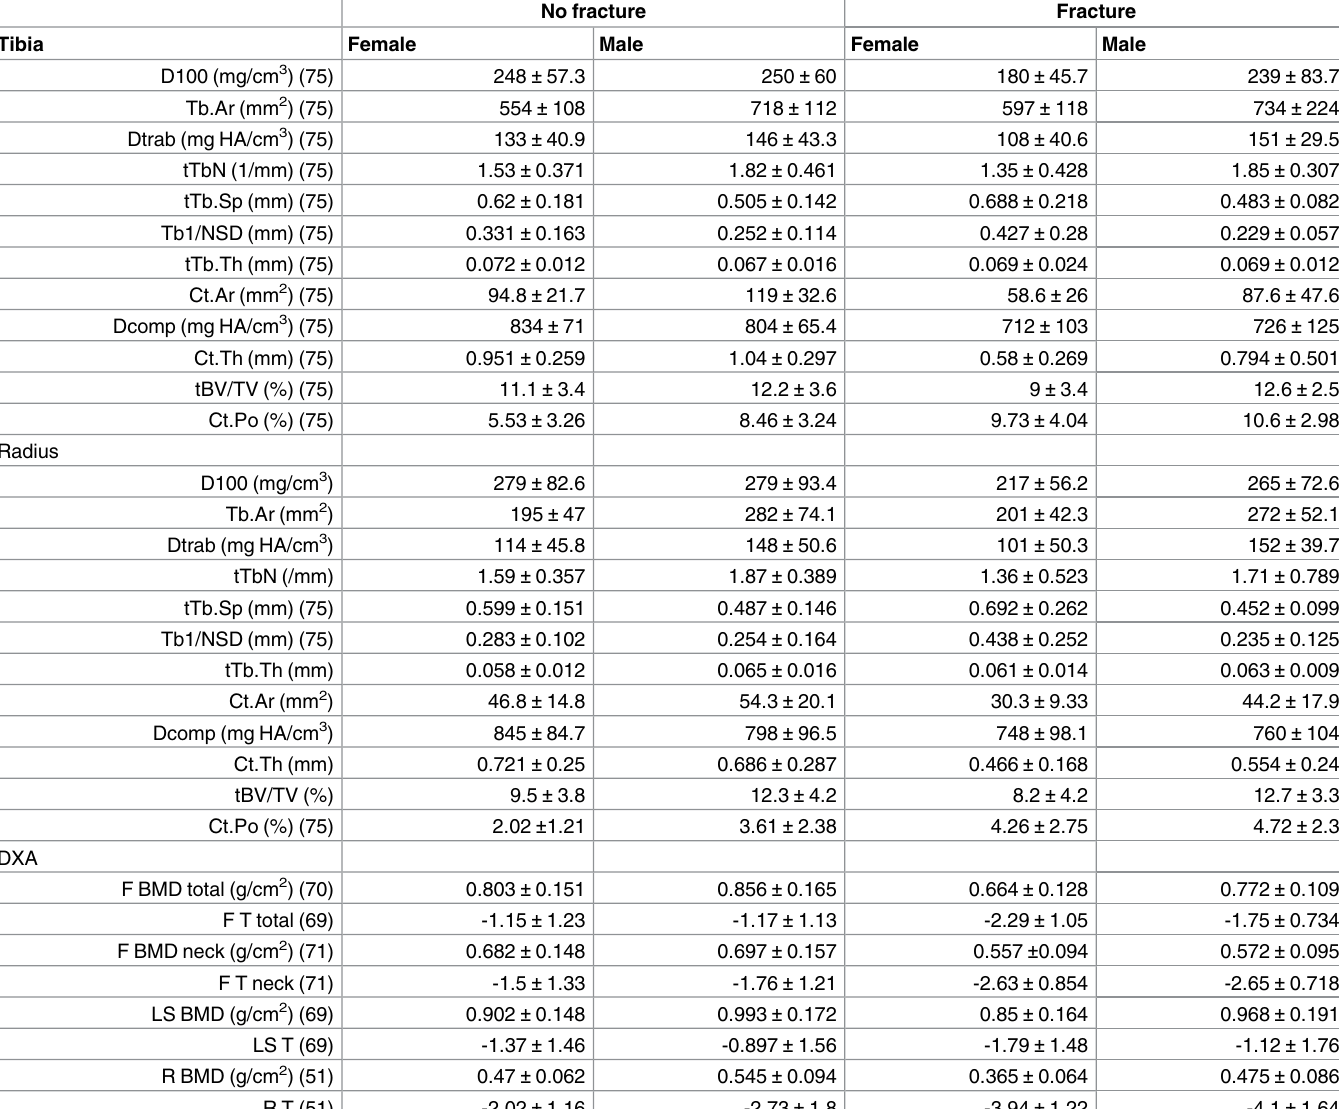
Table 2. Patient HR-pQCT morphometric data stratified according to fracture status and